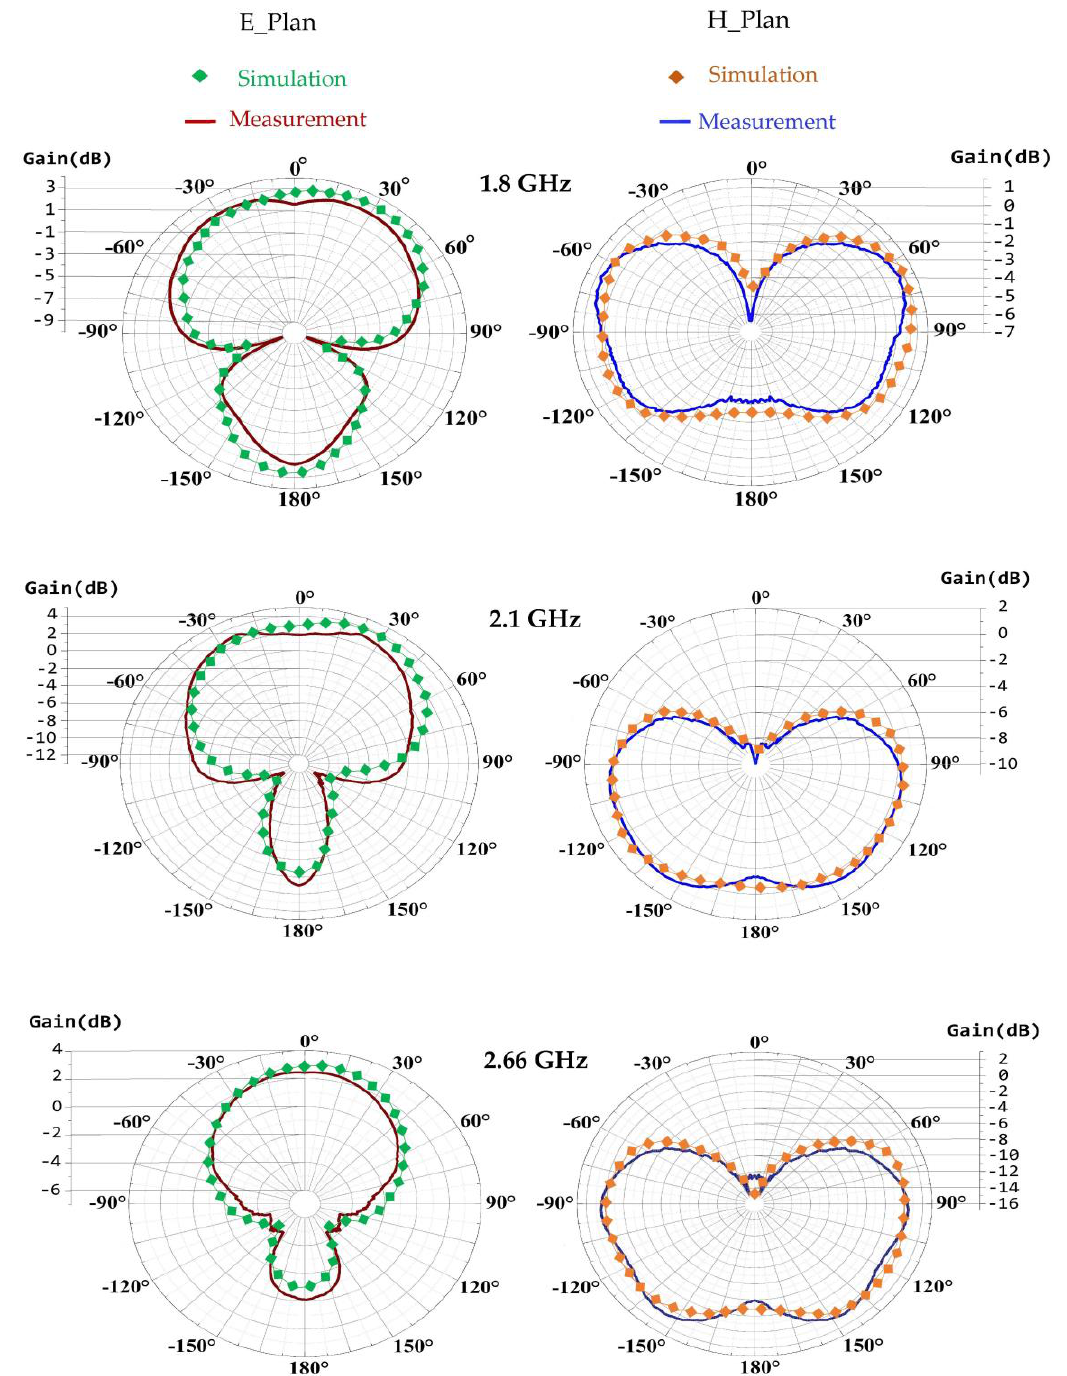
Figure 8. Simulated and measured radiation pattern for GSM, UMTS, and LTE bands, respec- tively.